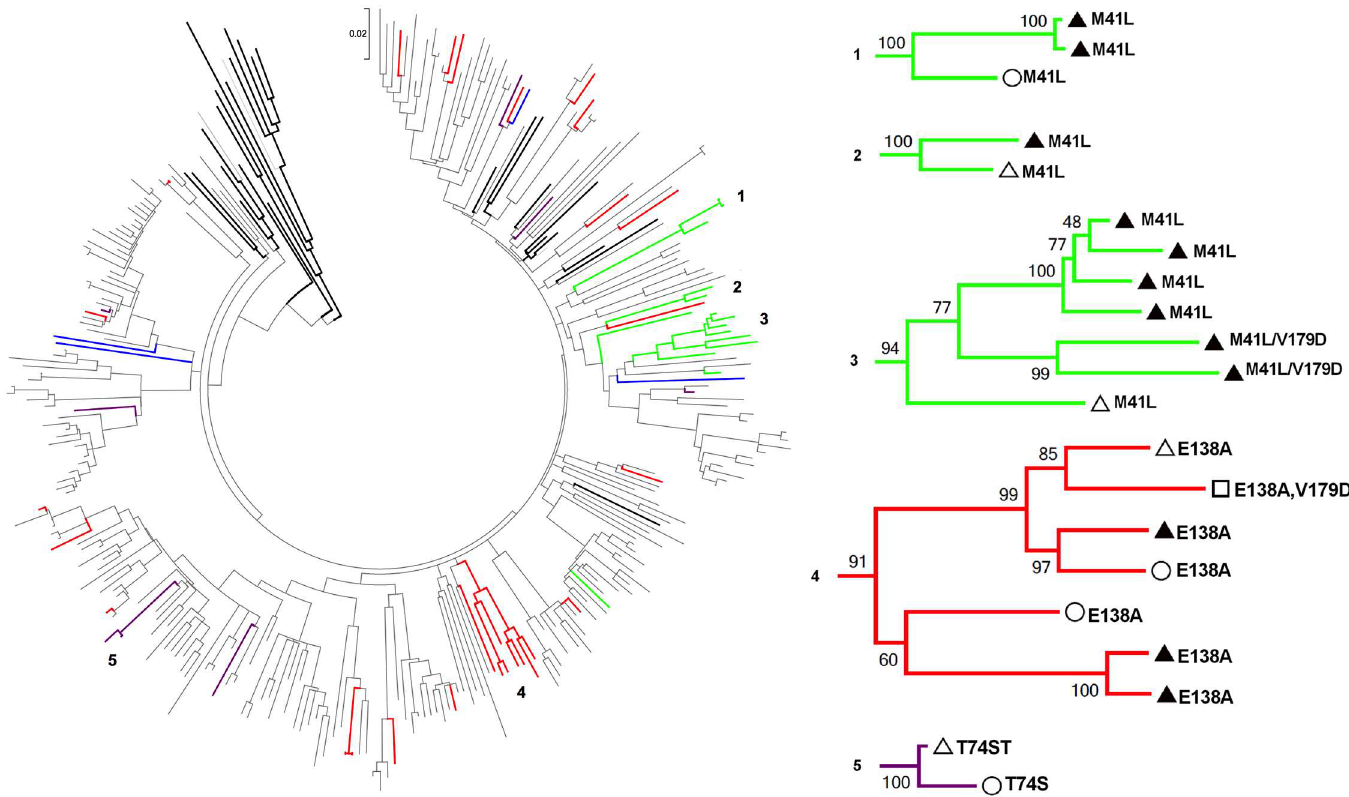
Fig 7. Phylogenetic relations between HIV sequences with PDR. A Maximum Likelihoodtree, built with the General Time Reversible + I + Γ model, without includingdrug resistance positionsis shown. 1000 bootstrap repetitionswere used to assess confidence. Viruses with PDR to PI (purple), NRTI (green), NNRTI (red) and more than one ARV class (blue) are colored. Reference sequences were obtained from Los Alamos HIV Database (bold). Five clusters of viral sequenceswith PDR with bootstrap values over 90% are amplified. Circle, females; empty triangle, heterosexual males; full triangle, self- identifiedmen who have sex with men; square, unknownrisk